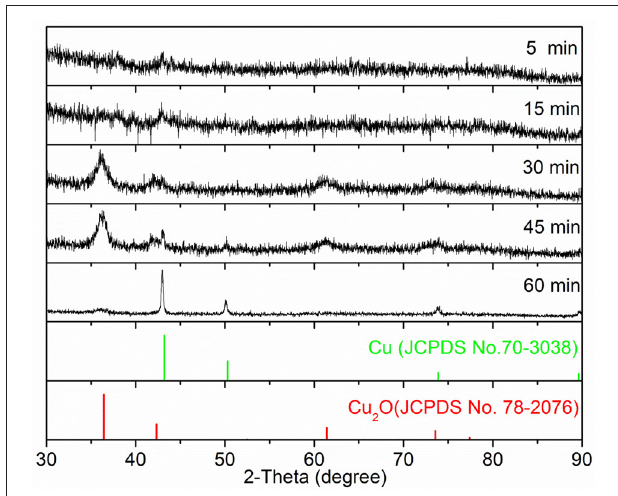
FIGURE 2 | The XRD patterns of samples as displayed in Figure 1